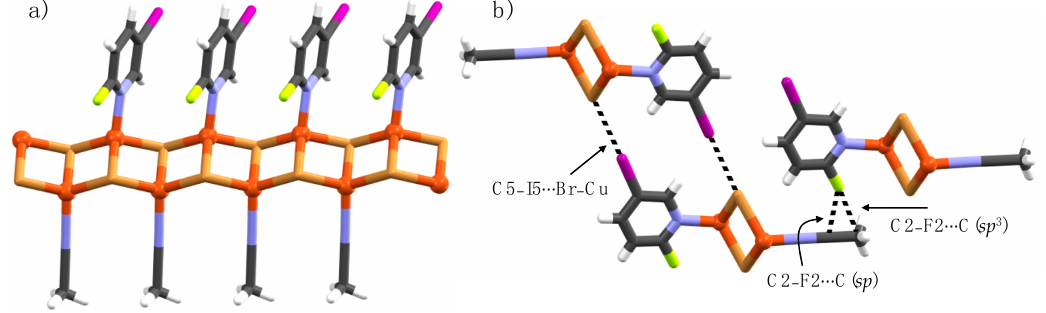
Figure 4. ( a ) 1-D Polymer view of 1a ･ ACN , and ( b ) section of crystal packing viewing halogen bonds and C2 − F2···C interactions (black dotted lines).